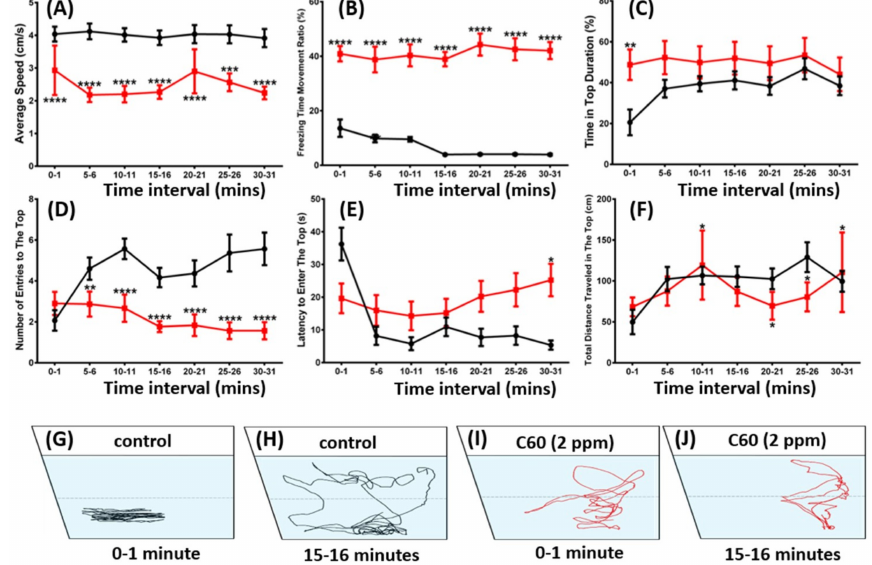
Figure 3. Comparison of behavior endpoints between wild-type and C 60 NPs-exposed zebrafish in novel tank exploration after five-day exposure. ( A ) Average speed, ( B ) freezing time movement ratio, ( C ) time in top duration, ( D ) number of entries to the top, ( E ) latency to enter the top, and ( F ) total distance traveled in the top were analyzed. The black line represented control and red line represented C 60 NPs-exposed fish in Figure 3A-F. The swimming trajectories of control (black color in ( G , H )) and C 60 NPs-exposed fish (red color in ( I , J )) for novel tank exploration test after 1 min and 15 min were recorded and compared. The data are expressed as the mean ± SEM and were analyzed by Mann–Whitney test ( n = 30 for control; n = 30 for C 60 NPs-exposed fish; * p < 0.05, ** p < 0.01, *** p < 0.005, **** p <